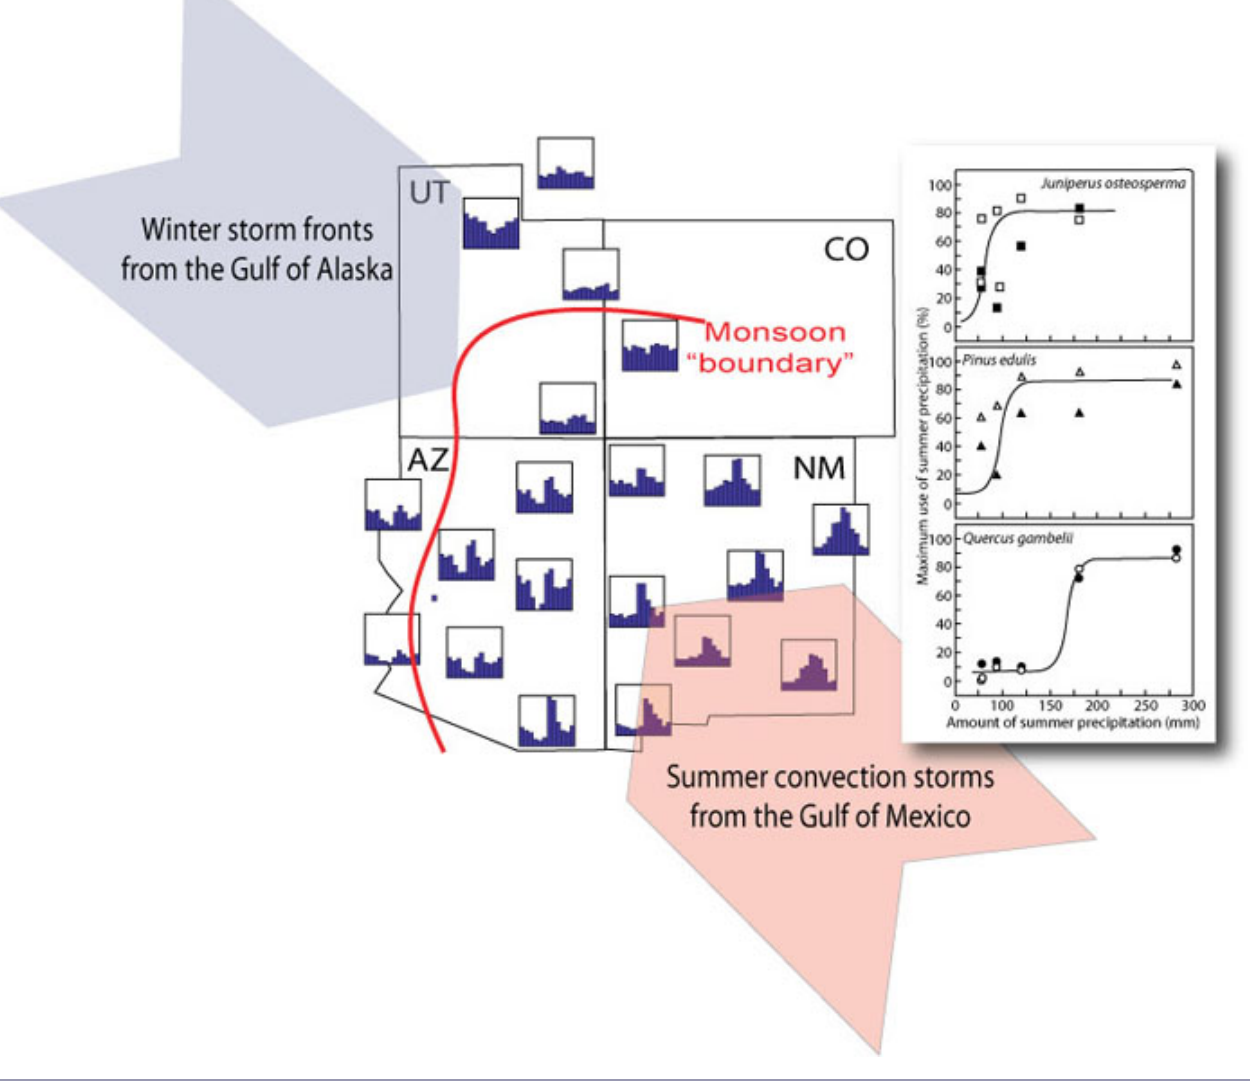
Fig. 2. The Colorado Plateau is located between the dry ends of two moisture trajectories coming from opposite directions (see text for details). Bar charts show average monthly precipitation values from January to December. Inset: maximum percentage of summer precipitation use in three tree species plotted against mean summer precipitation amount at a site (from Williams and Ehleringer 2000, courtesy of The Ecological Society of America). The data suggest a qualitative switch in responsiveness to summer rain across the monsoon